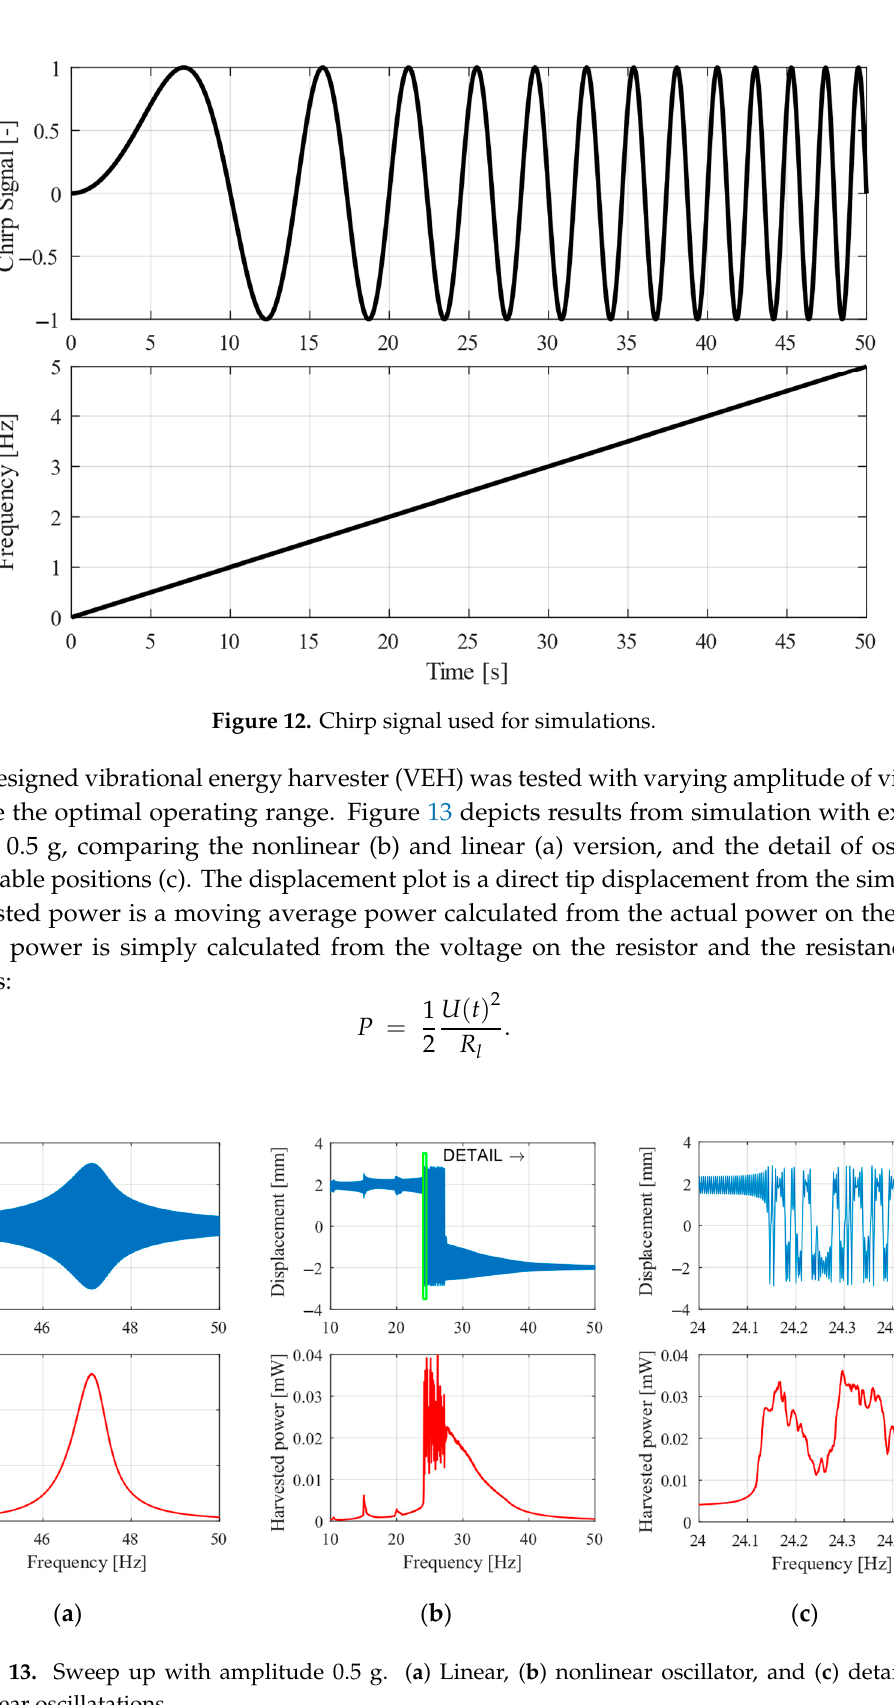
( c ) Figure 3. Sweep up with amplitude 0.9 g. ( a ) Linear, ( b ) nonlinear oscillator, and ( c ) detail of nonlinear oscillations. 6. Estimation of Critical Tip Displacement Amplitude The critical displacement of the beam’s free end is such a displacement amplitude upon which a potential surface crack propagates through the BaTiO 3 layer, and thus causes a malfunction of the whole multilayer structure. To determine critical displacement amplitude of the harvester’s free end, the stress intensity factor K appl at the tip of the crack within ATZ protective layers upon vibrations must not be higher than 11.7 MPa·m 0.5 (see the end of Section 2.1). The stress intensity factor K appl is defined through the weight function method as: ( )